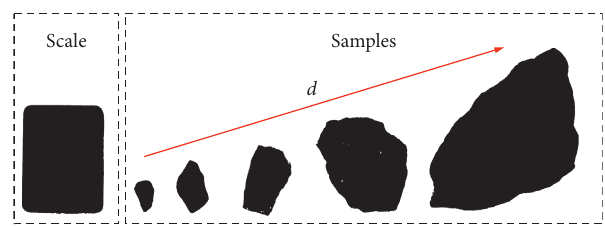
Figure 9: Binarization image of small rock